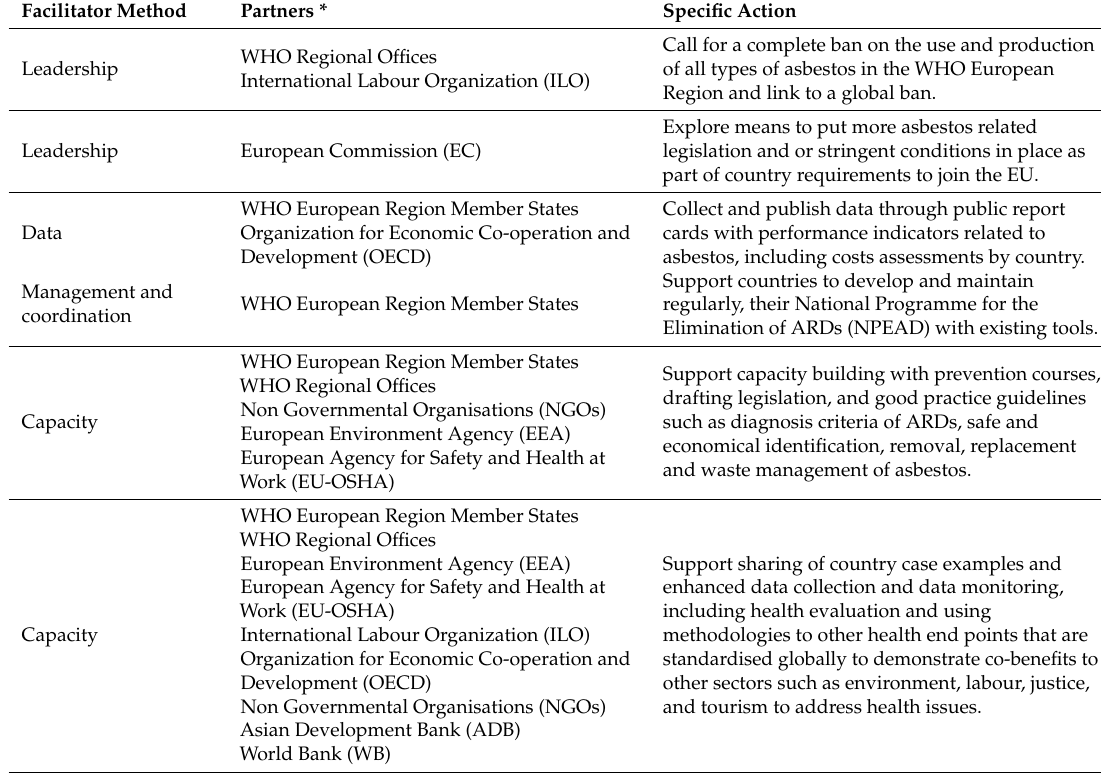
Table 1. Specific suggestions for partnerships to support elimination of asbestos related diseases